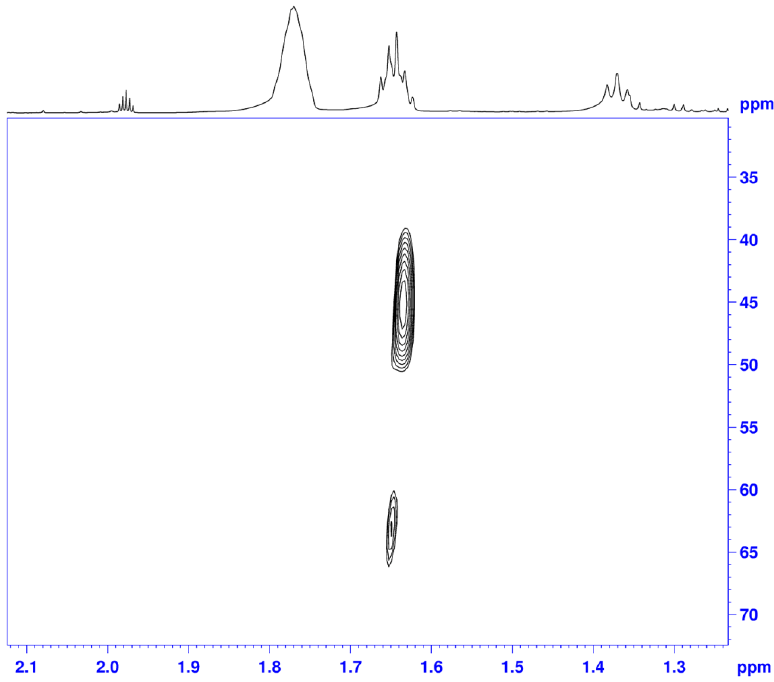
Figure 3. A section of a 1 H- 15 N gHMBC NMR spectrum of a mixture of catalyst [RuCl( η 6 - p -cymene)TsDPEN], HCOOH, piperidine- 15 N and acetonitrile- d